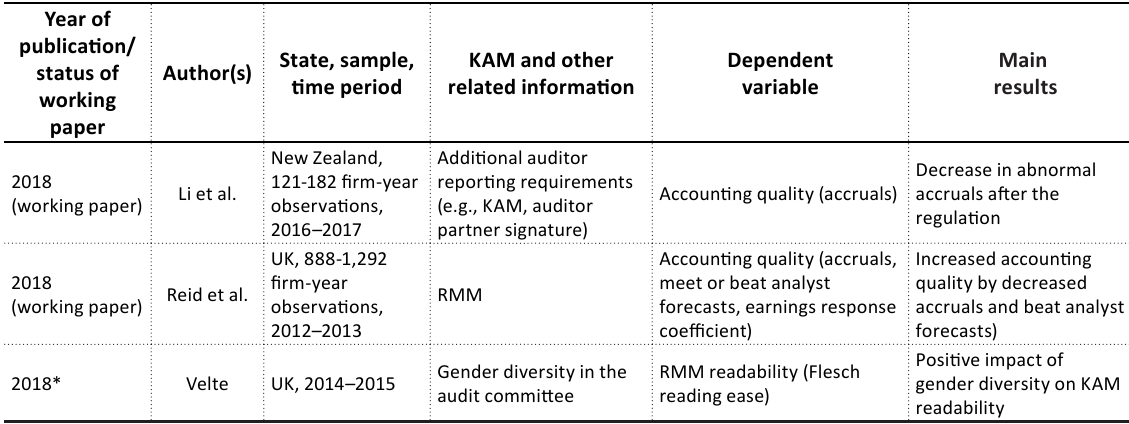
Table 6 (cont.). Overview of empirical research regarding the impact of KAM and other related information on boards of